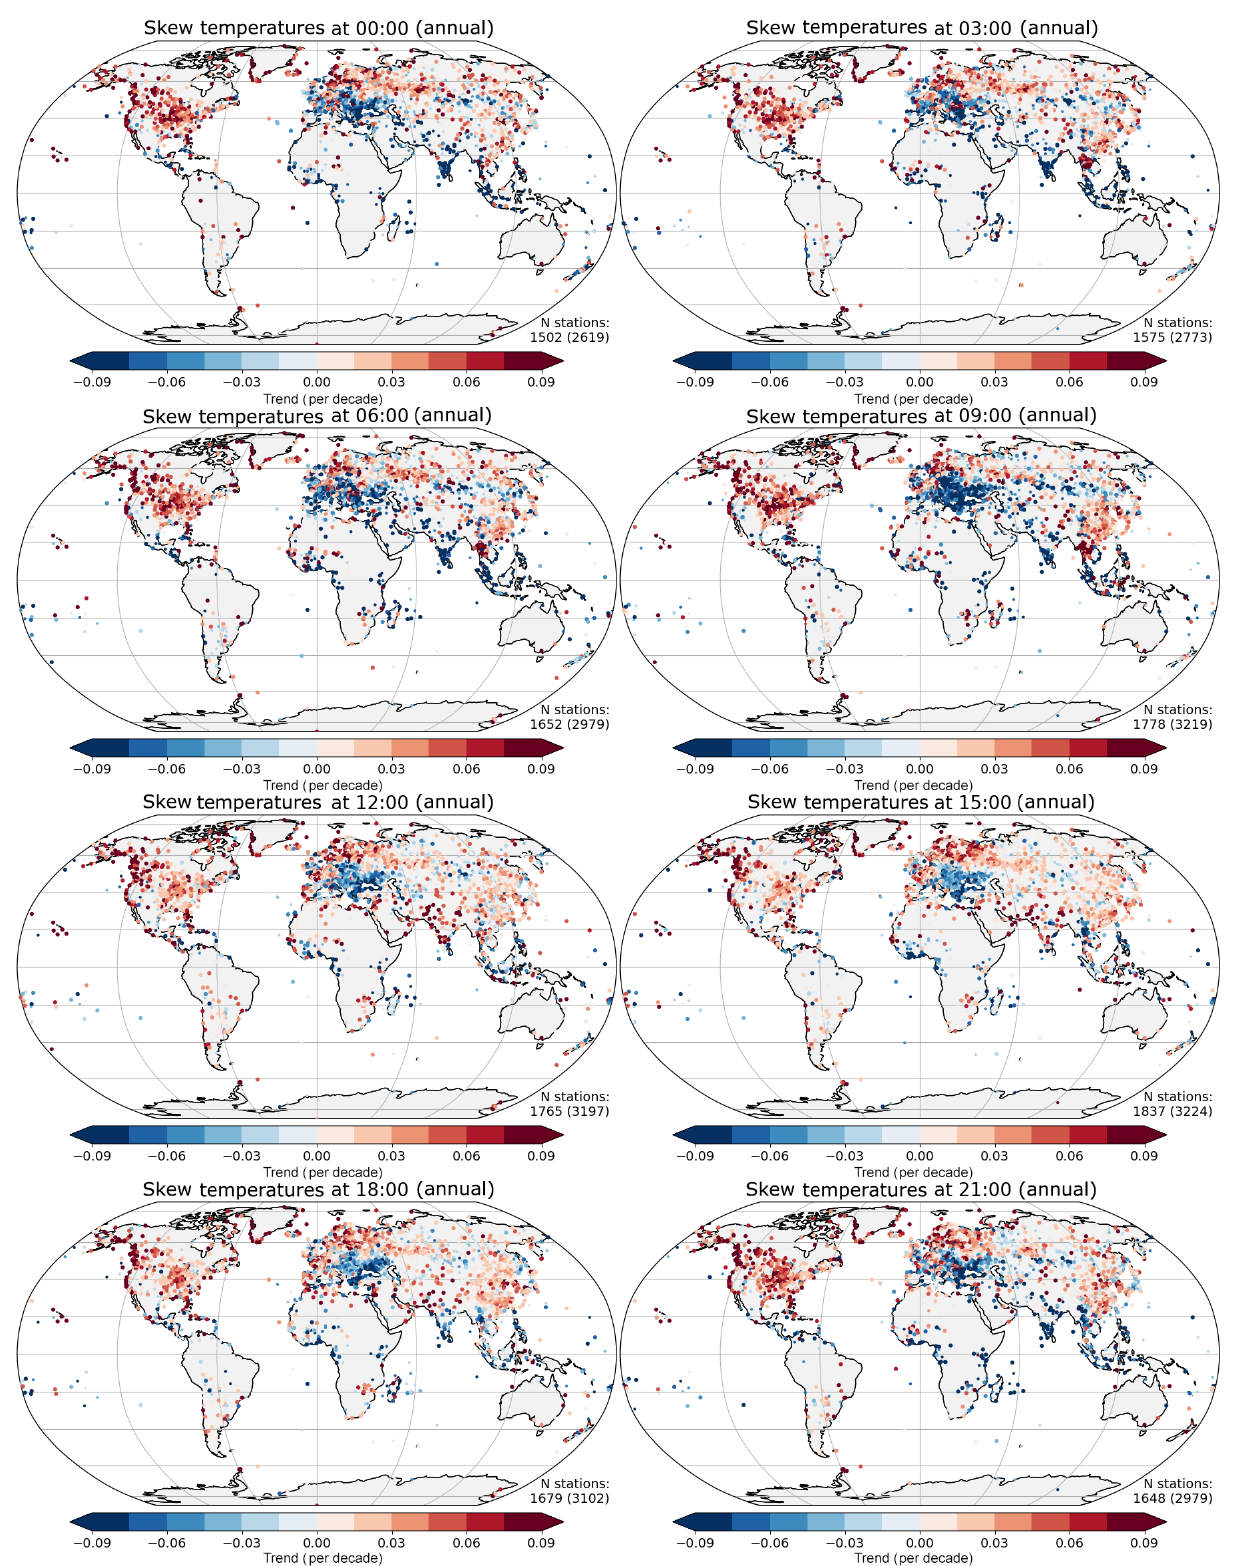
Figure 7. Trend over 1974–2018 in distribution skewness for temperature at each 3-hourly interval. The stations where the 1 ˆ σ range of the fitted trend excludes zero are plotted with a larger symbol (the number of these is shown in the bottom right-hand corner of each plot). The total number of stations available is shown in